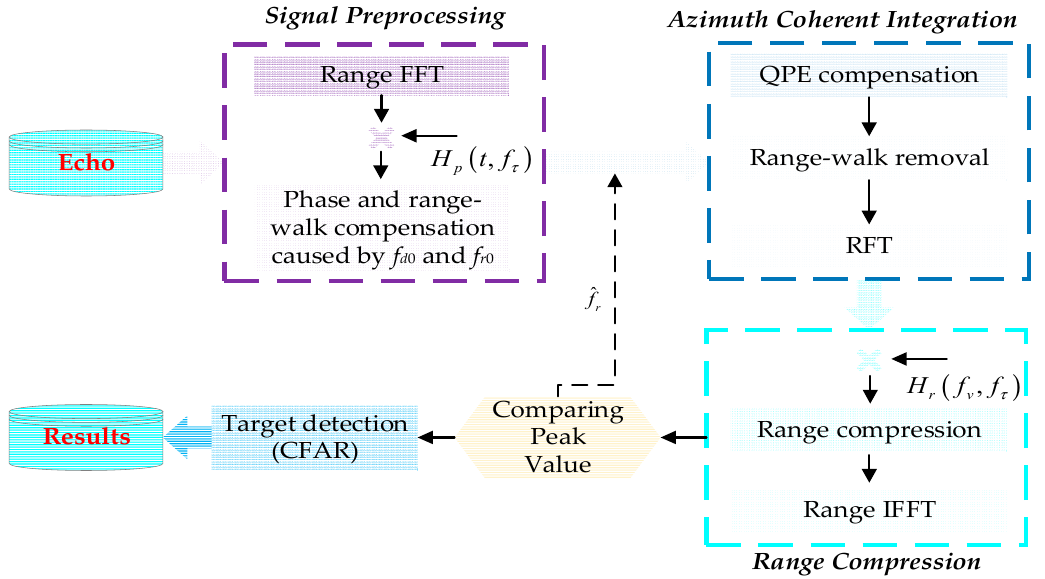
Figure 3. Framework of target detection using GNSS-based passive radar.